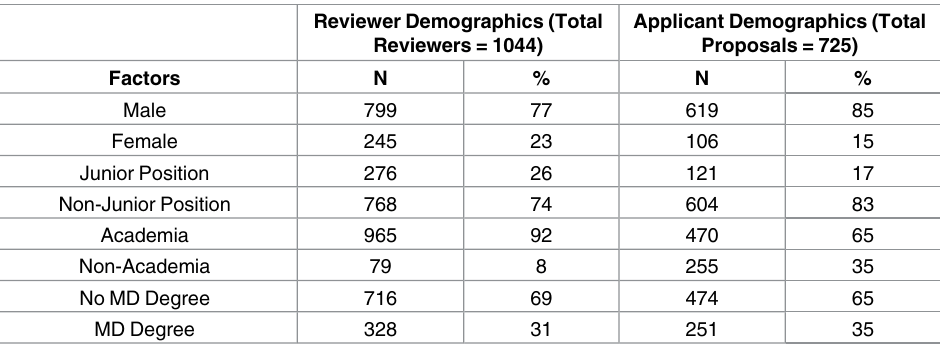
Table 2. Reviewer and applicant demographics